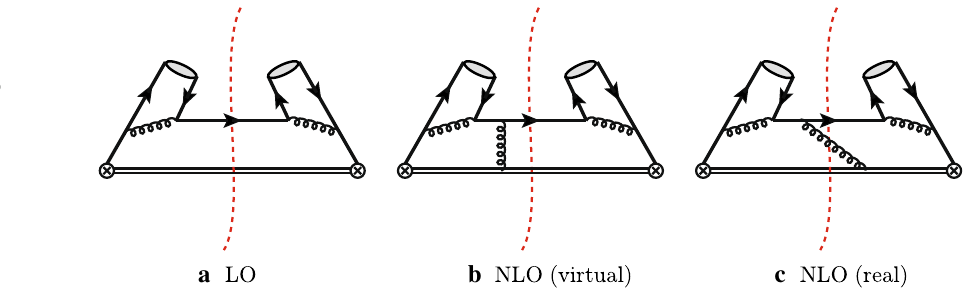
a b c 1 c is the N c -dimensional unit matrix. Because we are